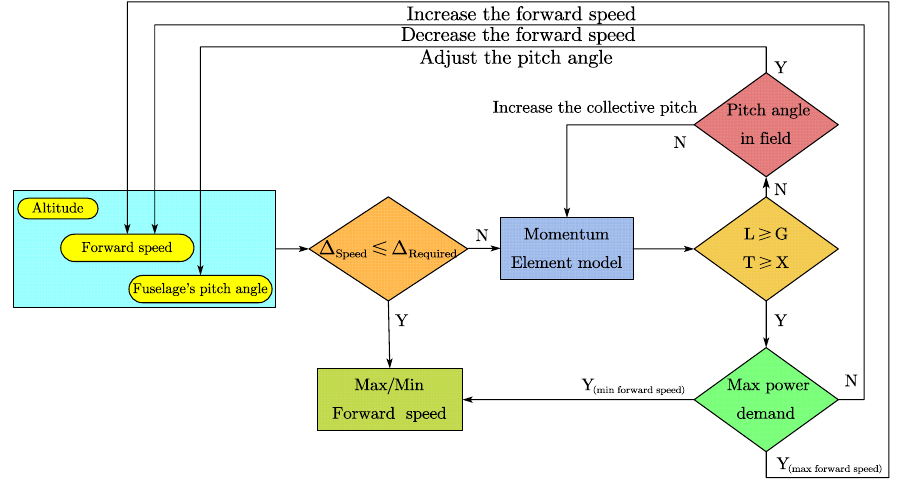
Figure 8. Flight envelope calculation flow.